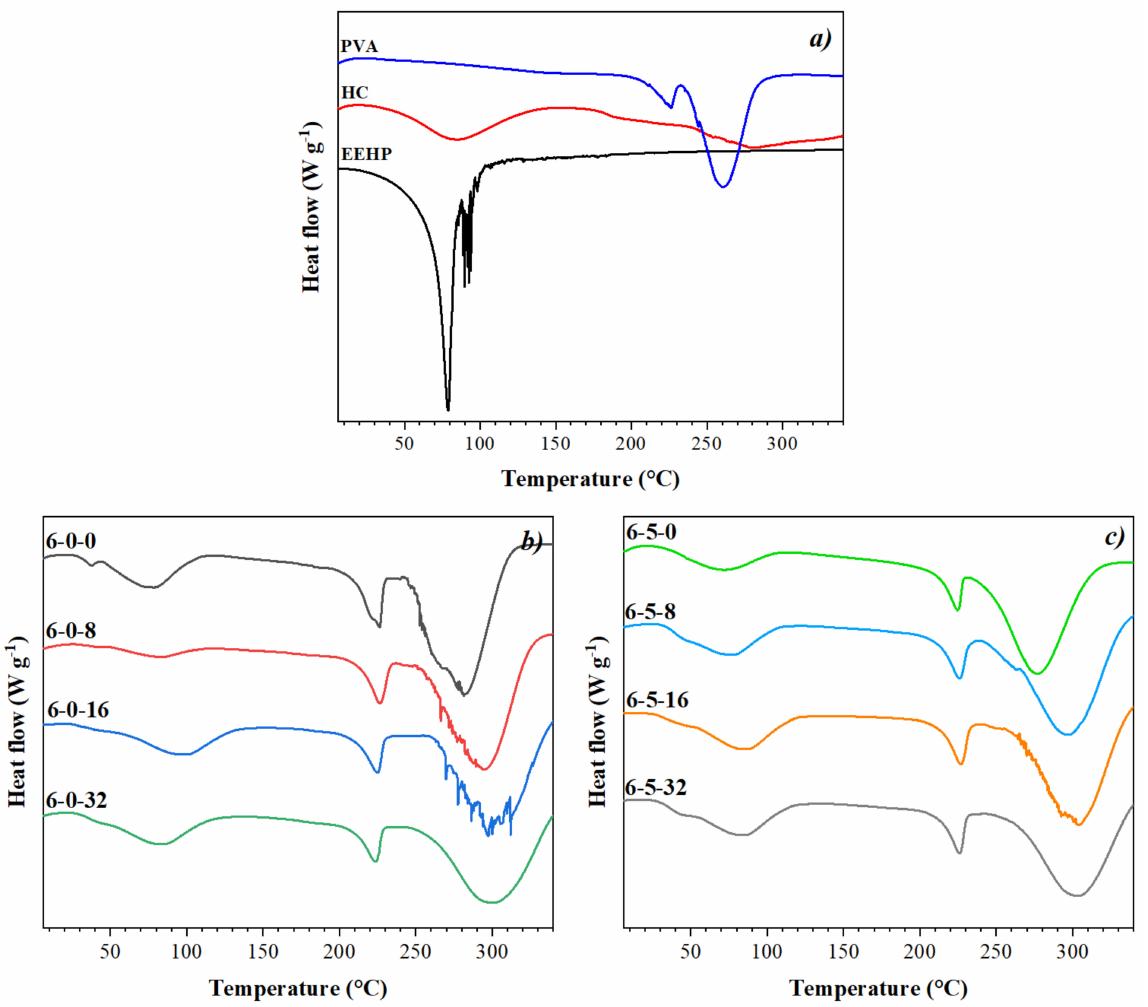
Figure 7. DSC thermograms of ( a ) the raw materials: hydrolyzed collagen (HC), ethanolic extract of Hypericum perforatum (EEHP), and PVA and ( b , c ) membranes obtained by electrospinning with PVA/HC/EEHP. (Nomenclature: % PVA (6)-% hydrolyzed collagen (0, 5)-% EEHP (0, 8, 16,